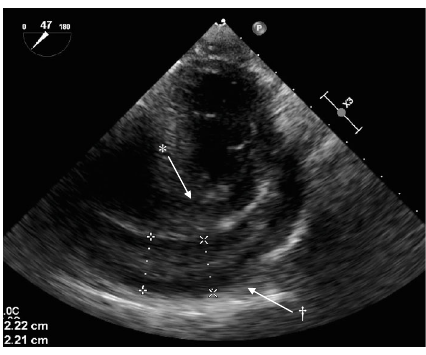
Figure 4: Transesophageal echocardiogram. Findings: ∗ right ventricular diastolic collapse with † pericardial e ff